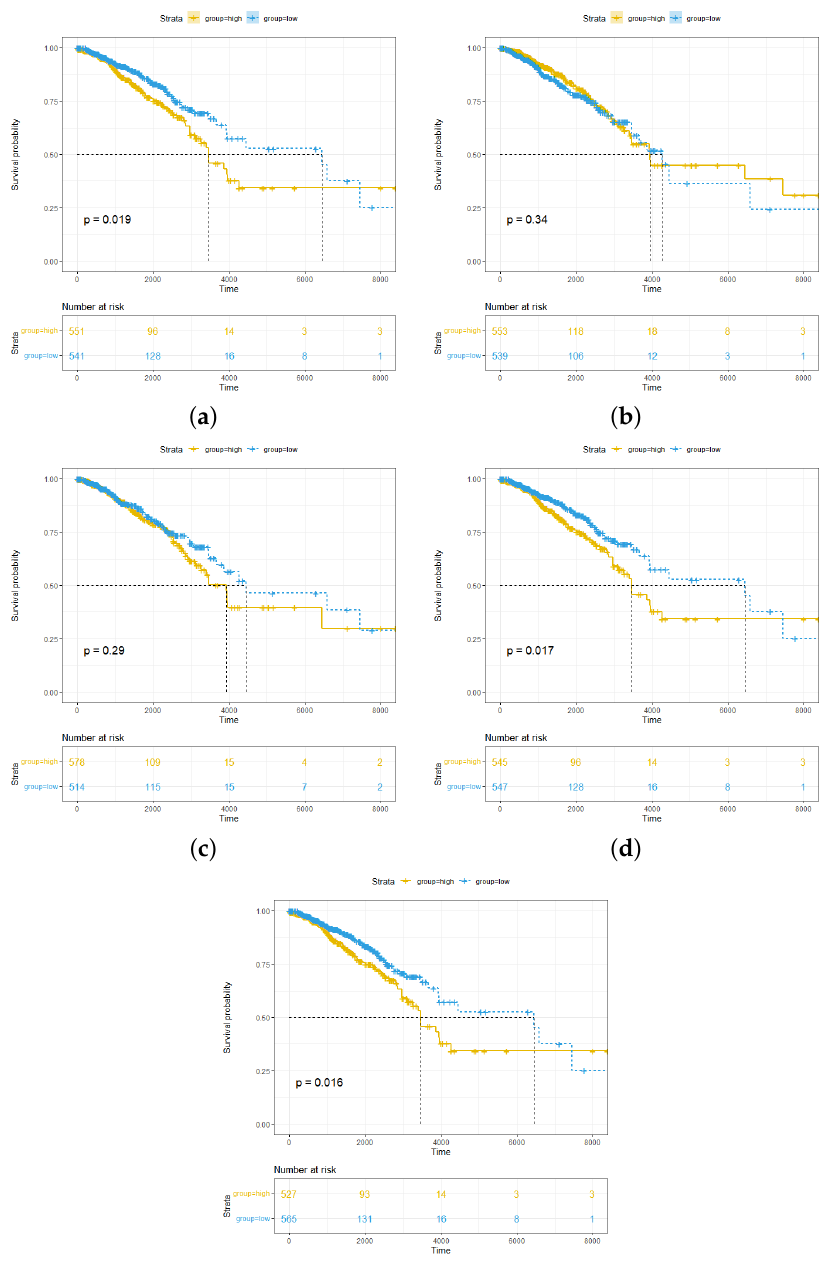
Figure 7. Correlation between clinical prognosis and hub gene expression in breast cancer patients. ( a ) Patients with low RBBP5 expression have better prognoses. ( b ) HNRNPU expression is not significantly associated with patient prognosis. ( c ) PEX19 expression is not significantly associated with patient prognosis. ( d ) Patients with low TPR expression have better prognoses. ( e ) Patients with low BCL9 expression have better